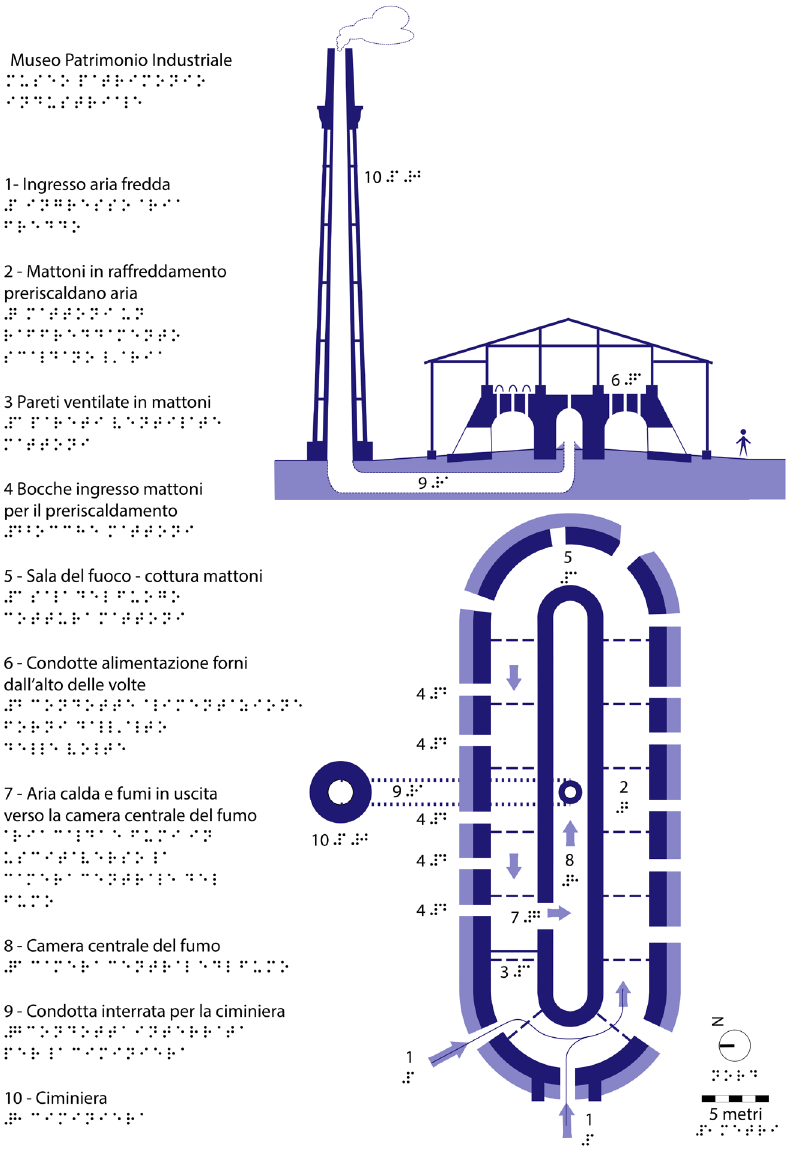
FIG. 3 Orientation and mobility tactile map design for the Industrial Heritage Museum of